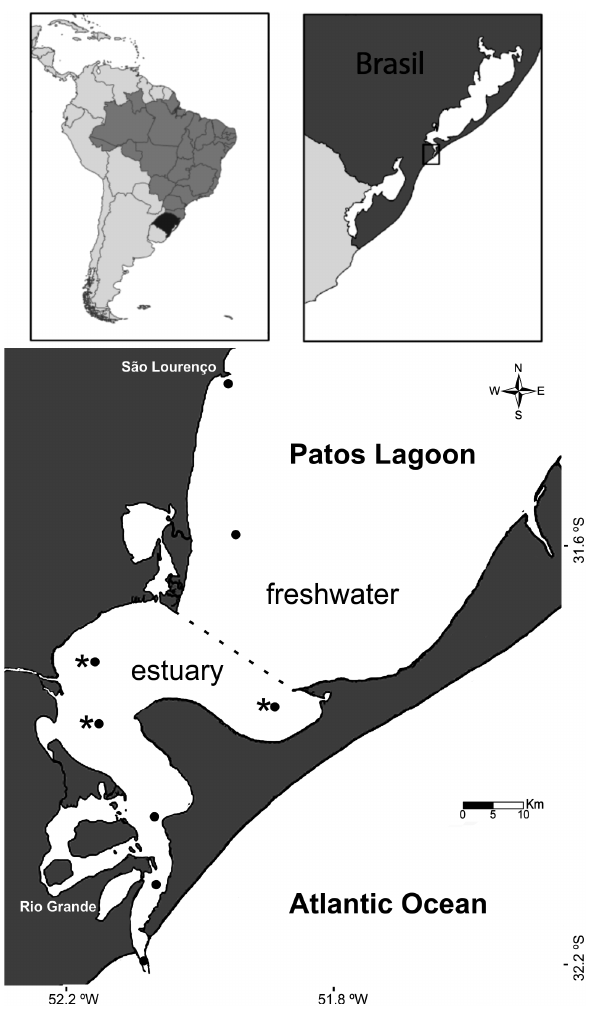
Figure 1. Map showing the sites in the estuarine and freshwater zones of Patos Lagoon, southern Brazil. Asterisks denote the locations where individuals of Genidens genidens and Genidens barbus were collected; closed circles denote the locations where marsh plants, seagrass, macroalgae and suspended particulate organic matter (SPOM) and sediment (SOM) samples were